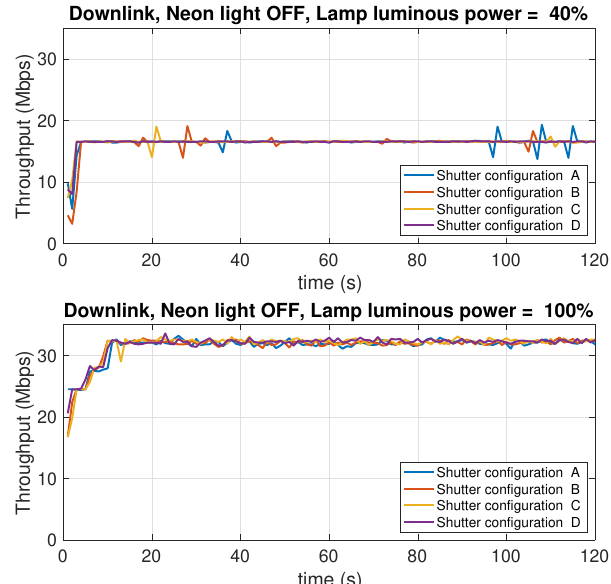
Figure 22. Downlink throughput with different shutter configurations (see Table 1). Neon lights OFF. LED lamp luminous power: 40% (top charts) and 100% (bottom charts) of the maximum luminous power of